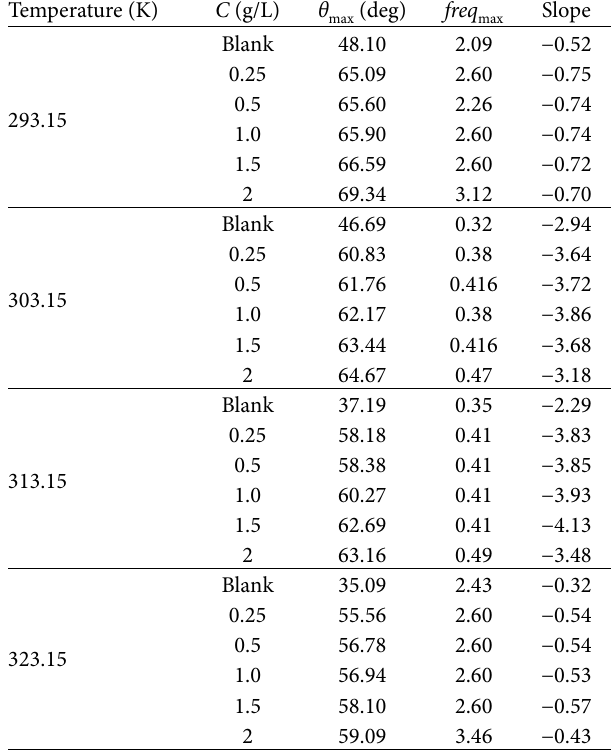
Table 3: Slopes of the Bode plots at intermediate frequencies, the ) and the corresponding frequencies maximum phase angles ( θ max ) for C38 steel in 1 M HCl solution containing different con- ( freq max centrations of HECG at different temperatures.